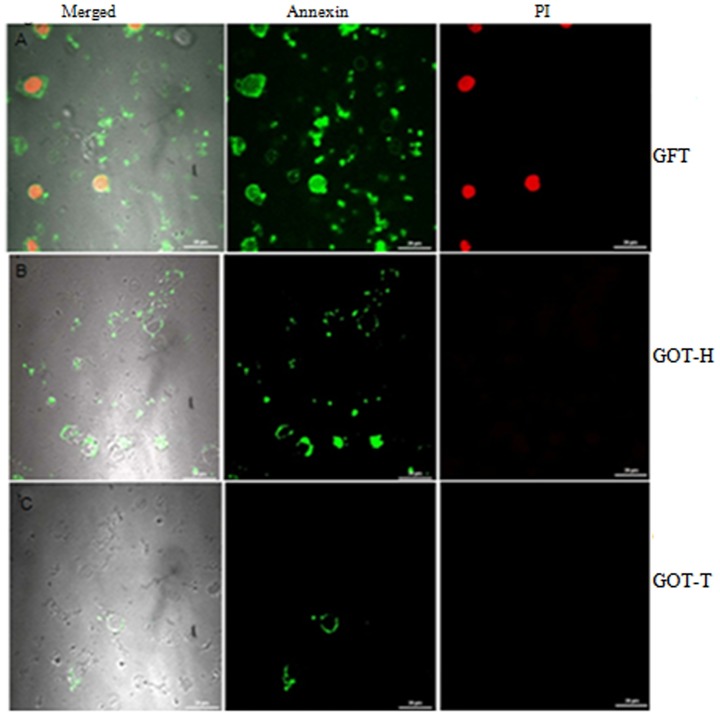
Evaluation of apoptosis with annexin V.Images of annexin V and propidium iodide (PI) fluorescence in granulosa cells are presented in Figs. 11 A–C. The granulosa cells from GFT group of rats (Fig. 11A) are clearly positive for both annexin V and PI fluorescence, which is indicative of loss of membrane integrity that characterizes apoptotic death. The cells isolated from follicle-deficient ovary (GOT-H) after ovary transplantation shows lesser annexin V binding, but without PI fluorescence (Fig.11B). The granulosa cells from the transplanted ovary (GOT-T) (Fig. 11C) also show very limited annexin V binding and no PI fluorescence. Each image is one representative of 9 replicates; three replicates from each granulosa cell pool, and each pool represented by ovaries from 6–8 rats.